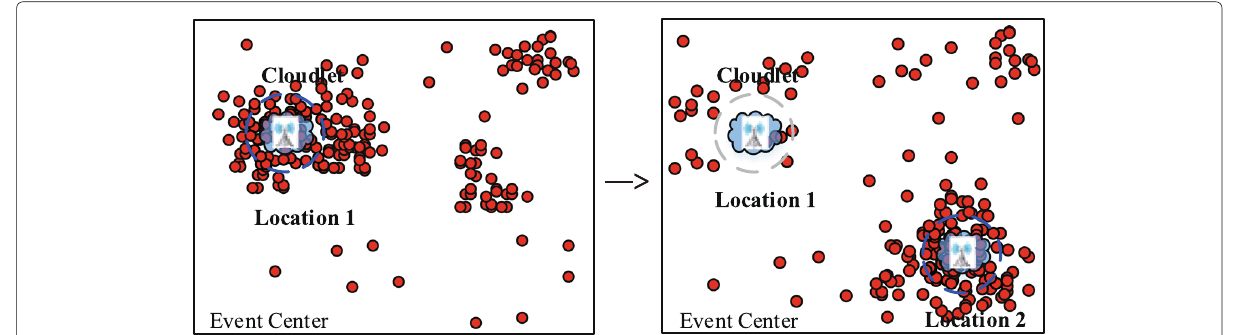
Fig. 1 The movement of people in a realistic application